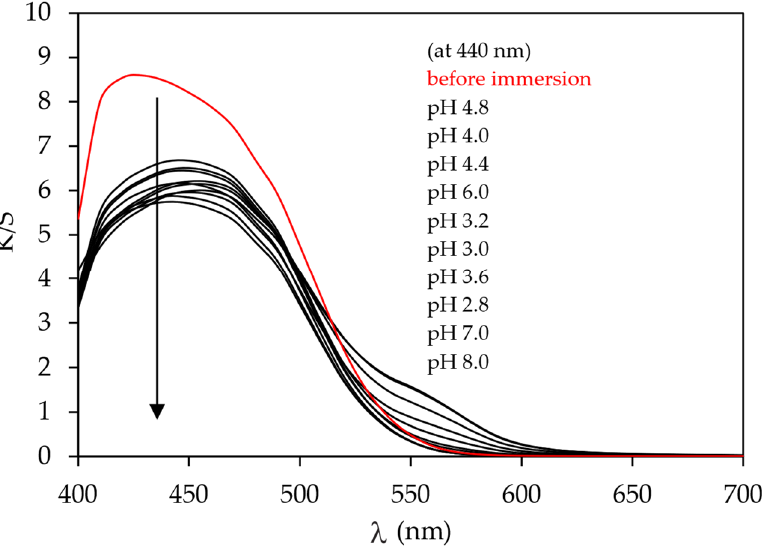
Figure 6. Values of K / S in dependence of the wavelength ( λ ) of sample CT_CO_D at different pH values.